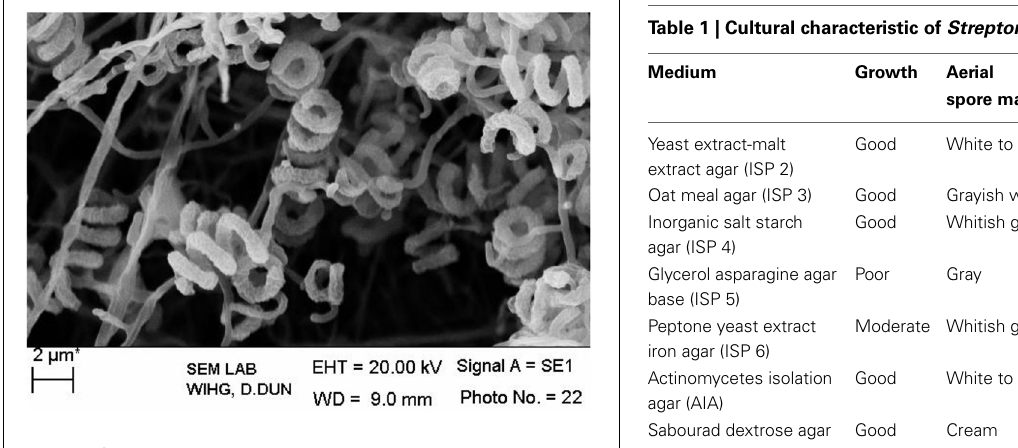
FIGURE 1 | Scanning electron micrograph showing spore chain morphology of Streptomyces sp. MN 2(6); Bar, 2 µ m.